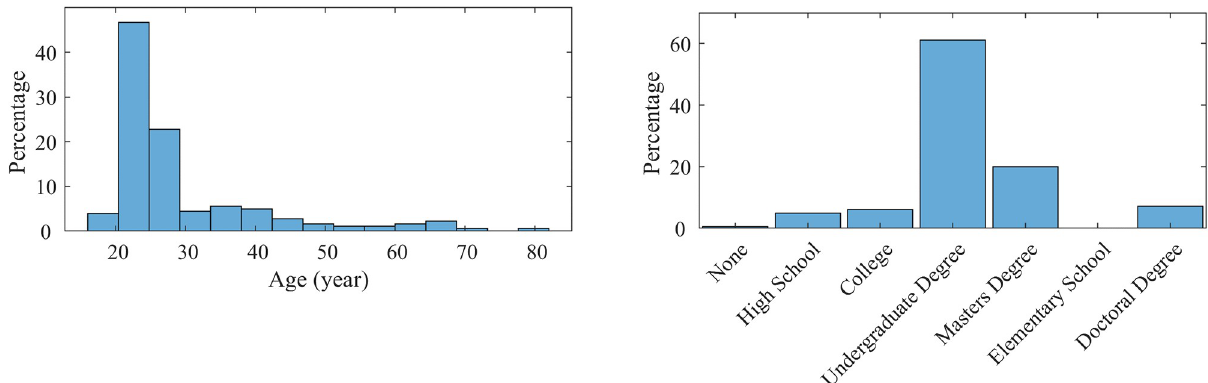
Fig 1. Demographics: Age and education distribution of participants.